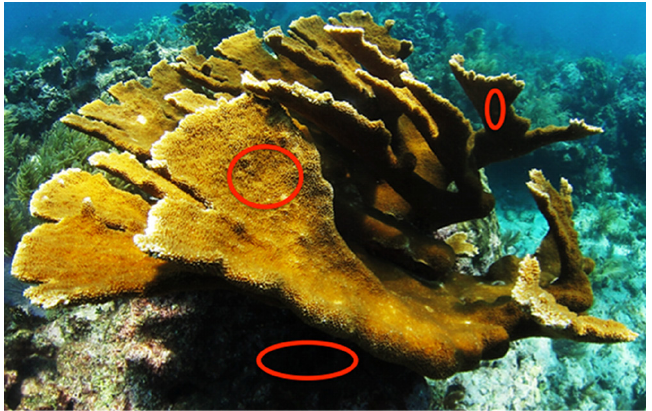
Fig 1. Regions of the surface mucus layer (SML) sampled (uppermost, underside, base) from A . palmata